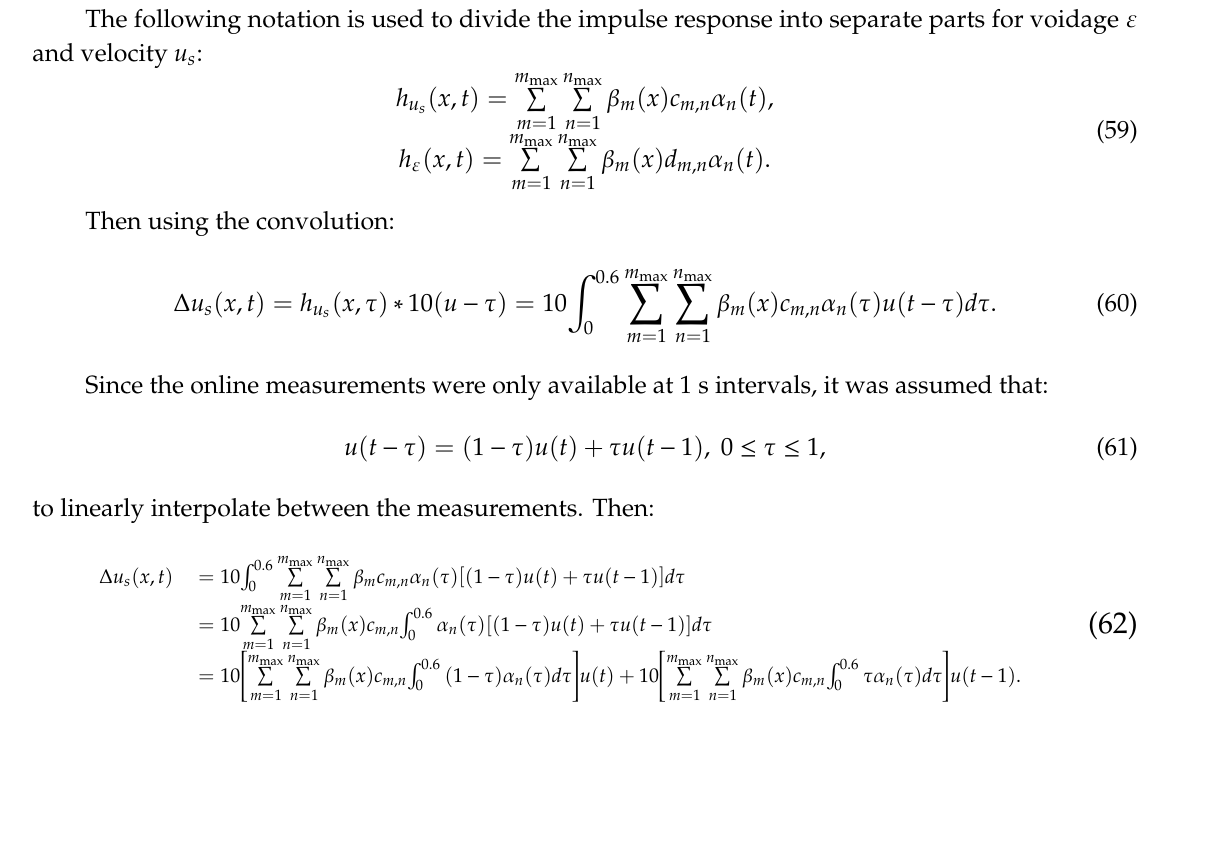
Figure 15. Wavelet-approximated impulse response h ( x , t ) : ( a )—the solid velocity response approximation, ( b )—the voidage response approximation.